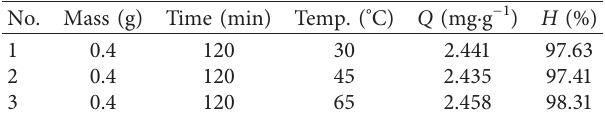
Table 11: Effect of temperature on methylene blue adsorption process.